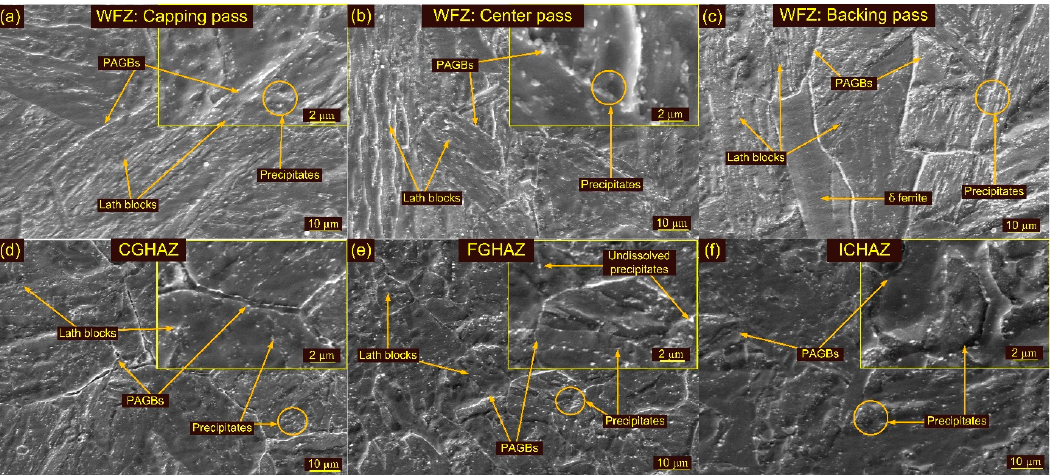
Figure 14. SEM images of weldments after HT1 treatment: WFZ ( a ) capping pass, ( b ) center pass, ( c ) backing pass; ( d ) CGHAZ, ( e ) FGHAZ, ( f ) ICHAZ. Optical images of the WFZ after HT2 treatment are depicted in Figure 15a–c. The WFZ corresponding to the capping pass shows lath blocks and lath packets within the PAGBs. The lath blocks had different orientations within lath packets. Coarsening of the grains is also seen in the WFZ. The PAGs’ sizes in the capping, center and backing passes were 28 ± 5 µm, 40 ± 6 µm and 31 ± 4 µm, respectively. The WFZ corresponding to the